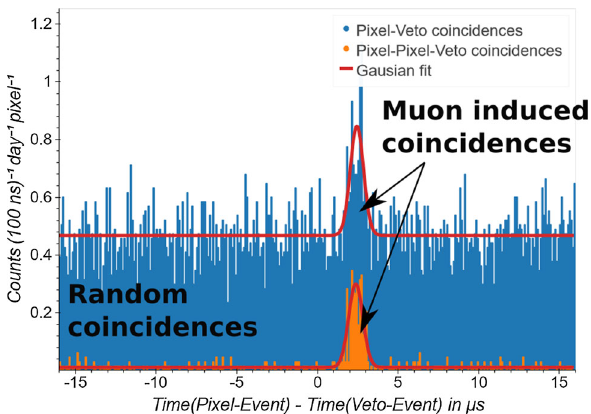
Fig. 9 The time difference δ t between the pixel events and muon veto events δ t = t ( pixel event ) − t ( veto event ). The events shown in blue are all pixel events coincidental to the muon veto and the events, which are in addition coincidental to other pixel events are showed in orange. A peak at δ t ≈ 3 µ s is visible in both. The flat spectrum corresponds to random coincidences between pixel events and muon veto, the events in the peak are induced by muons, which cross the muon veto and interact with the